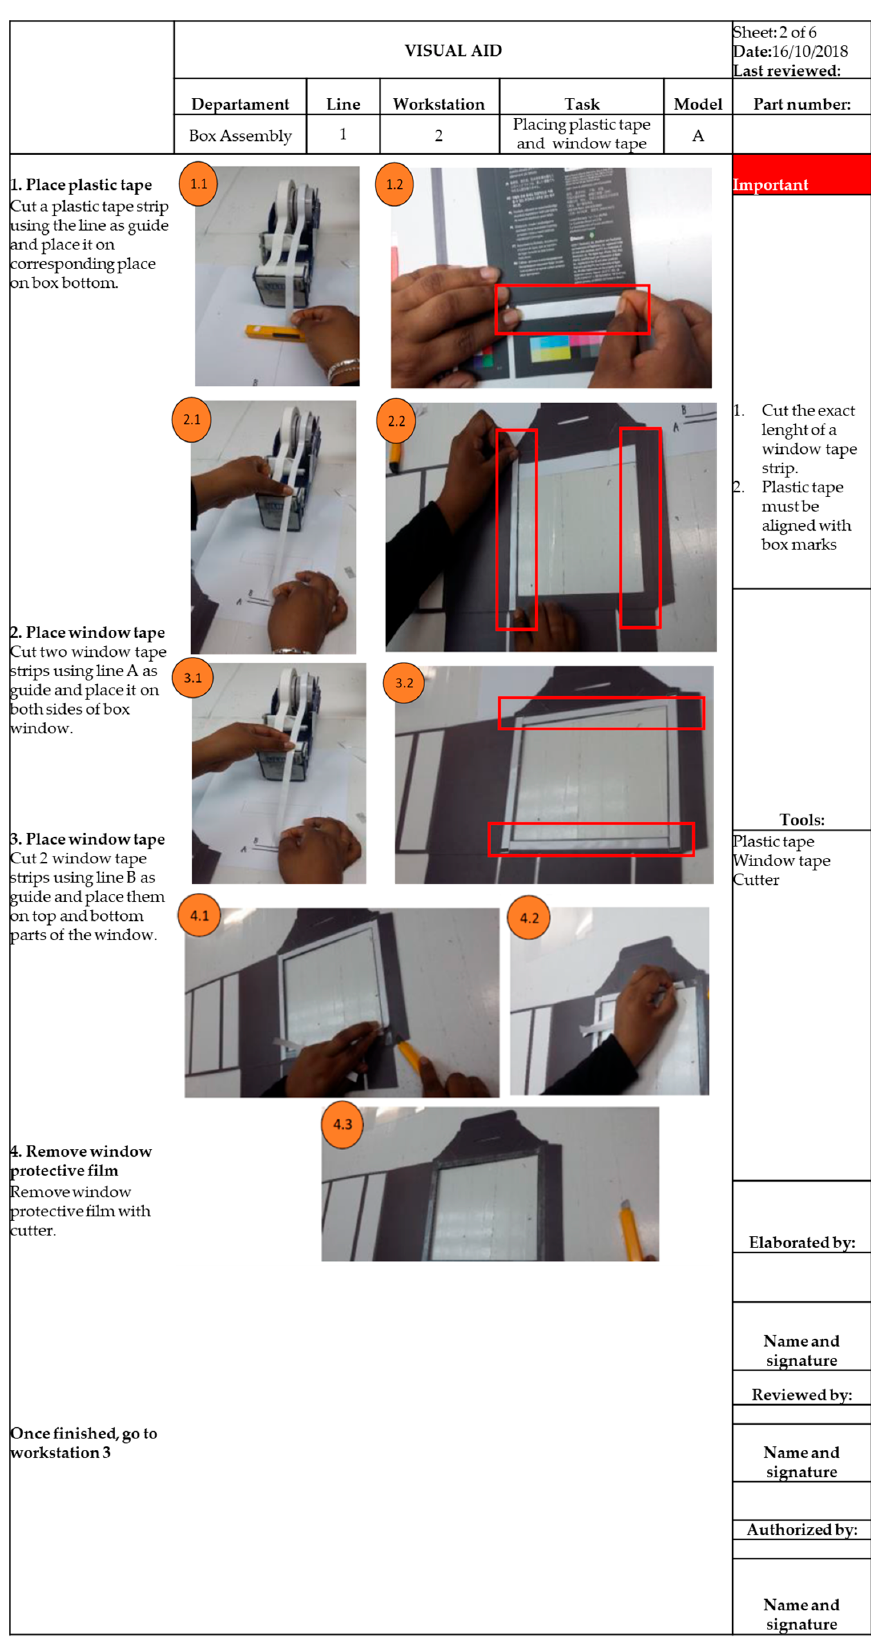
Figure 5. Visual aid for the redesigned workstation 2.